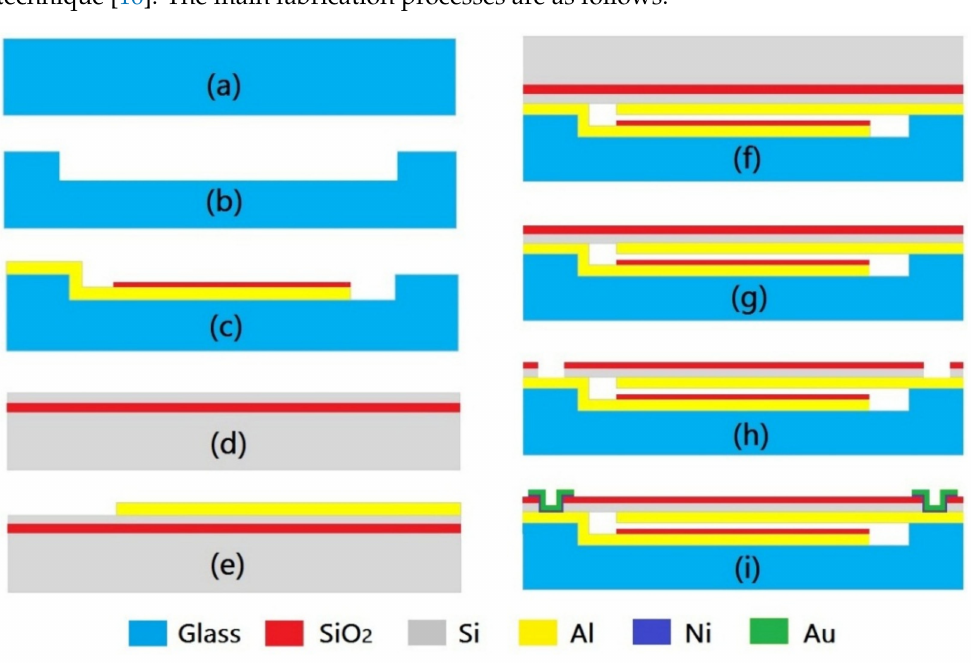
Figure 4. Self-packaged fabrication process flow of MEMS-based CPSs. ( a ) Glass wafer; ( b ) Etch- ing cavity; ( c ) Depositing Al and SiO 2 ; ( d ) SOI wafer; ( e ) Depositing Al; ( f ) Two wafer